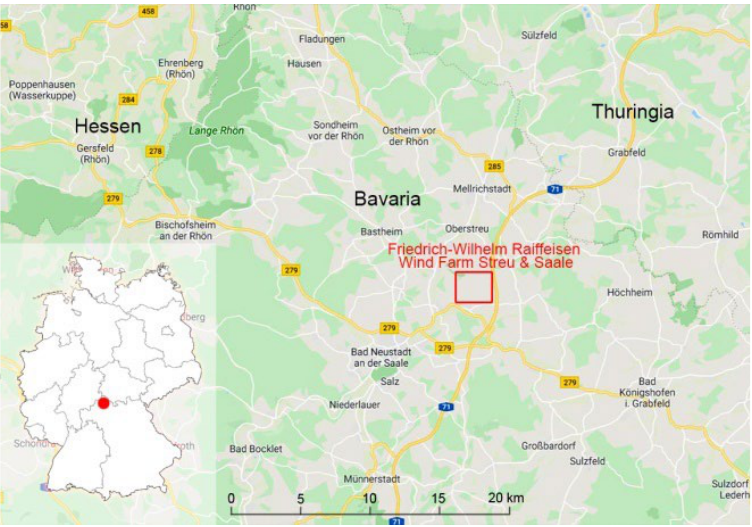
Figure 2. Location of Friedrich-Wilhelm Raiffeisen Wind Farm (Source: ArcGIS Earth). The wind farm consists of 10 WTs in the type of Senvion 3.4 M 122 NES, each with a nominal output of 3.4 MW and a total height of 200 m (hub height 137 m and rotor diameter 126 m). They are erected on the farmland with a total capacity of 34 MW.